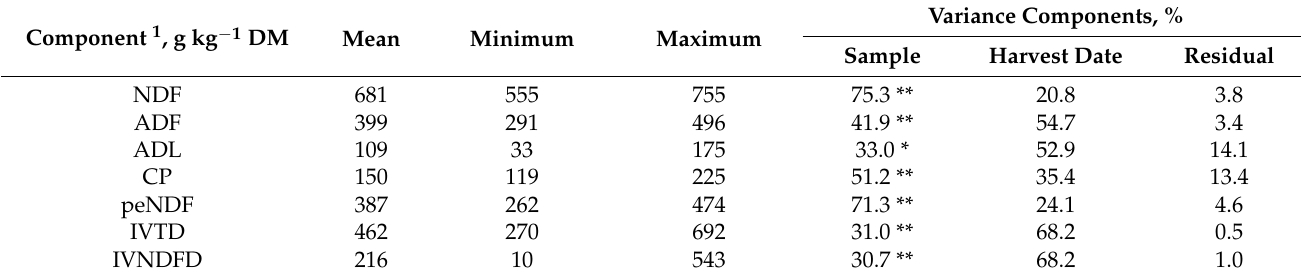
Table 1. Nutritive value and in vitro digestibility of dried paunch manure obtained from cattle harvested at the Tarleton Meats Laboratory, Stephenville, TX, USA.